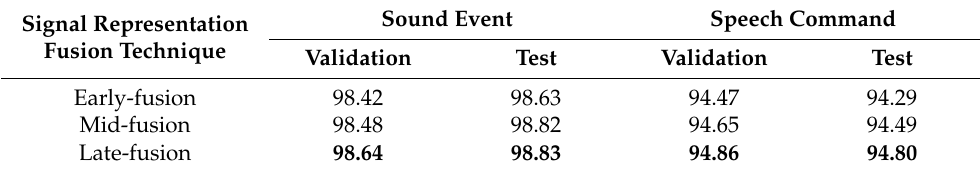
Table 5. Average classification accuracy (in %) of signal representation fusion